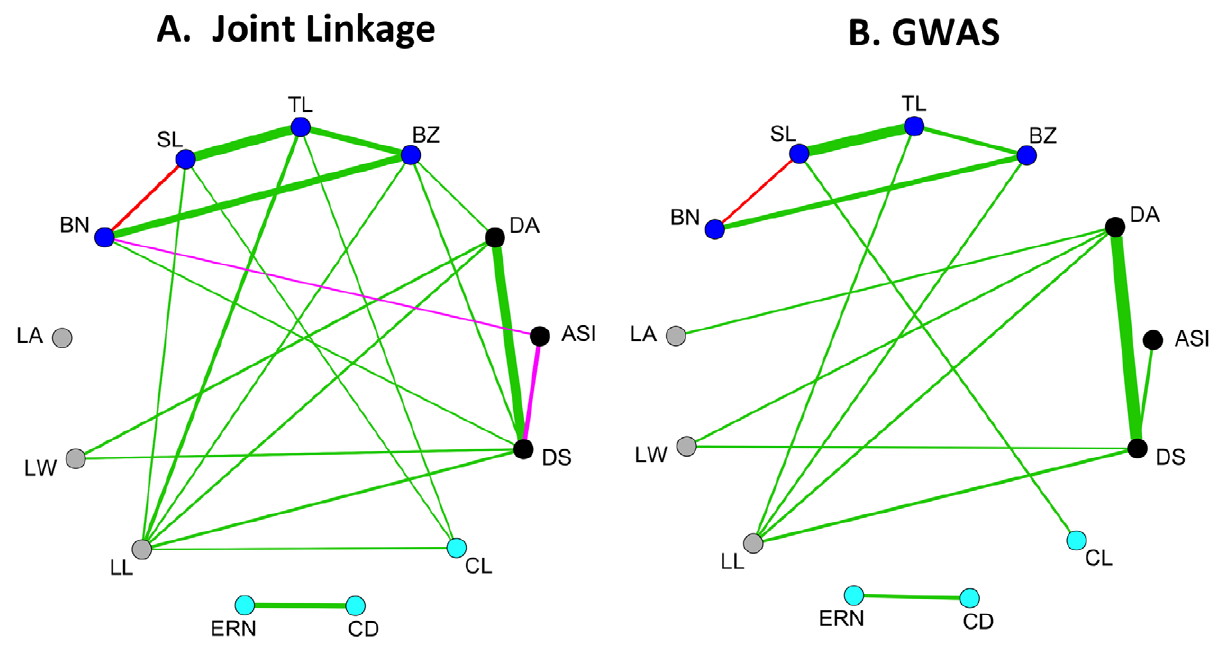
Figure 5. Pleiotropy for maize morphological traits. Green, red, and purple lines between traits indicate positive, negative, and both positive and negative correlations between QTL effects, respectively, with line width proportional to the degree of pleiotropy. A significance cutoff of p , 0.01 (r . 0.495 in a two-tailed test with 24 d.f.) was used for effect correlations. To eliminate spurious correlations, lines are only displayed for trait pairs with at least 10% pleiotropy. A. Pleiotropy assessed using joint linkage analysis. B. Pleiotropy assessed using GWAS. 5 cM sliding windows with a 2.5 cM step were used (see Materials and Methods), and only windows for which both traits had RMIP sums of at least 0.1 were considered. Trait abbreviations are the same as in Figure